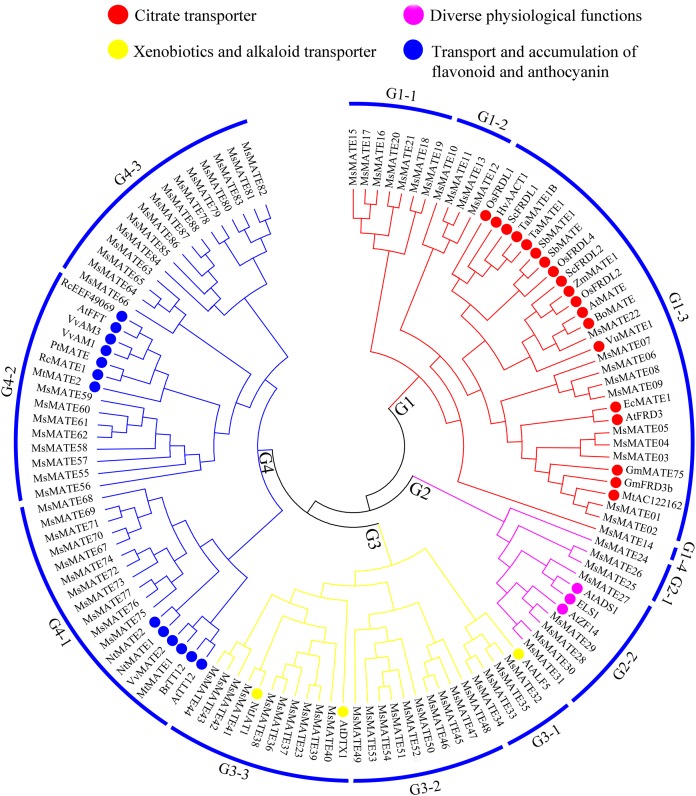
Functional annotation of MATE proteins from alfalfa and other plants.The phylogenetic tree was constructed using MEGA7.0 and the neighbour-joining method with 1,000 bootstrap replicates. The tree was divided into four subfamilies comprising 12 smaller subgroups.